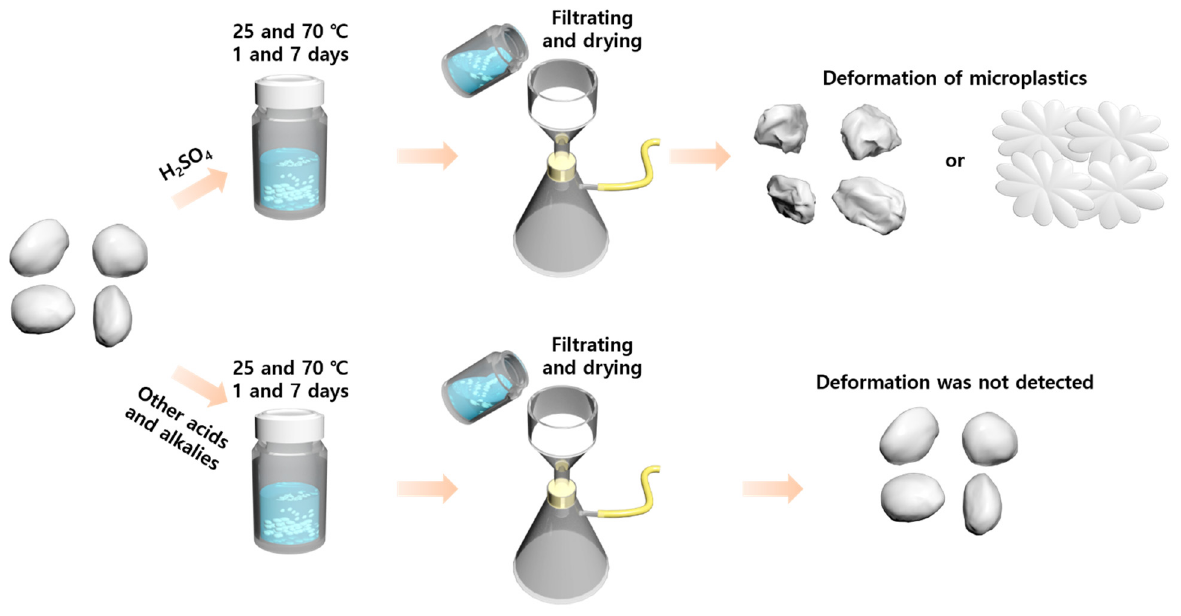
Figure 1. Schematic of the chemical stability test procedure for the microplastic samples (HDPE, LDPE, PP, PET, and PS) against chemical agents (H 2 SO 4 , HCl, H 2 O 2 , KOH, and NaOH) used in the chemical digestion